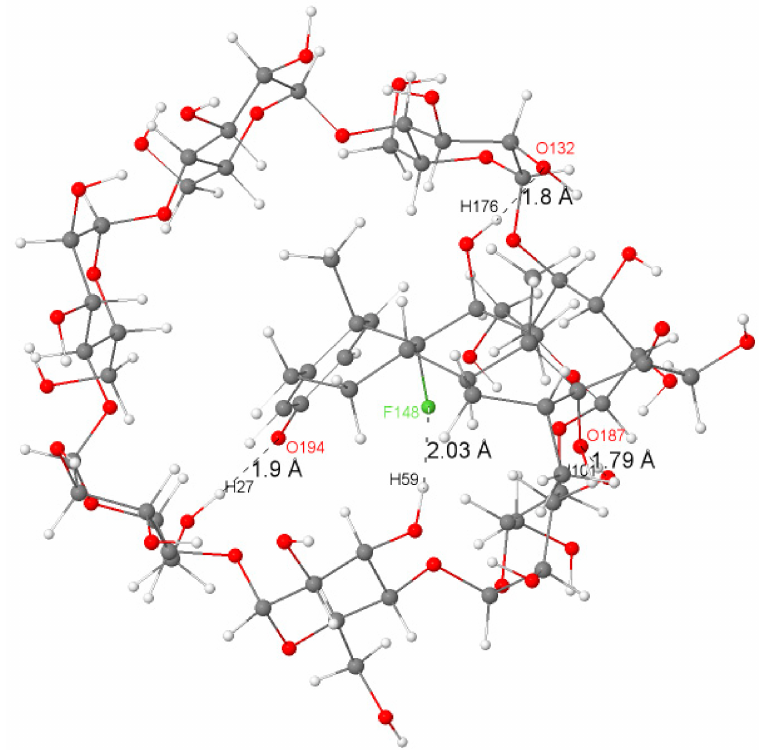
Figure 3. The significant H-bonds (in angstrom) between dexamethasone and β -CD in the Dex@ β - CD complex.